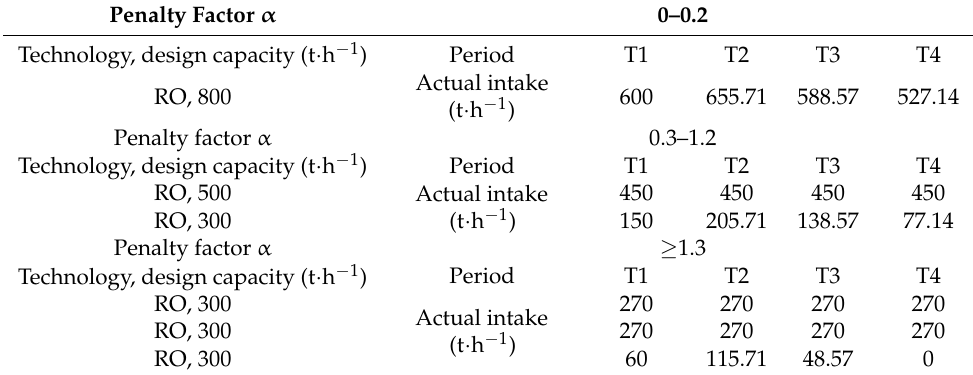
Table 6. Optimal operation scheme under different penalty factors (Scenario 2).